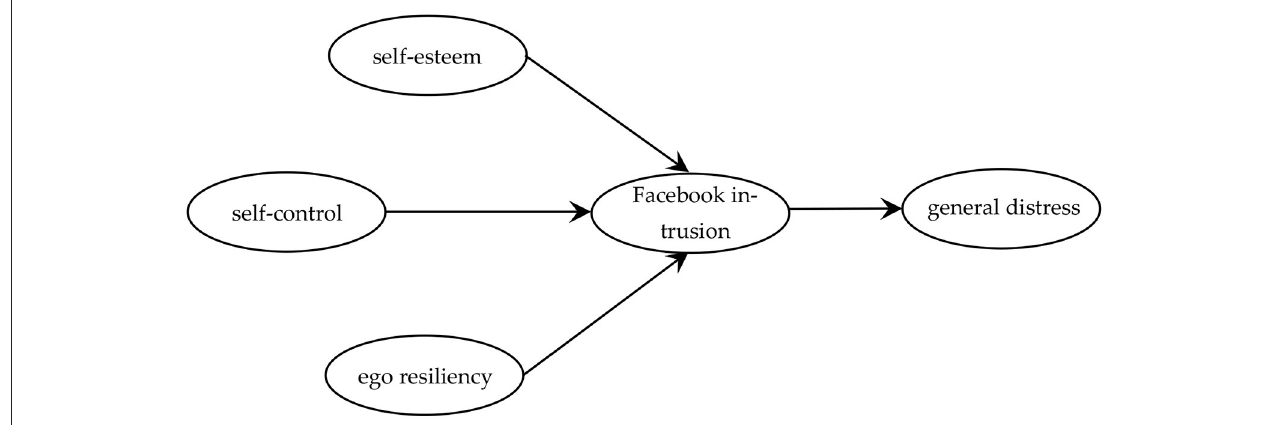
FIGURE 1 | Theoretical associations between the